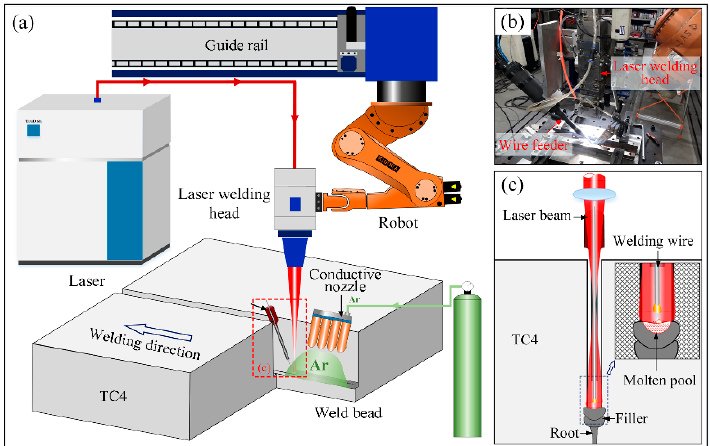
Figure 2. ( a , c ): the schematic diagram of the NGLW process; ( b ) the NGLW experimental equipment.